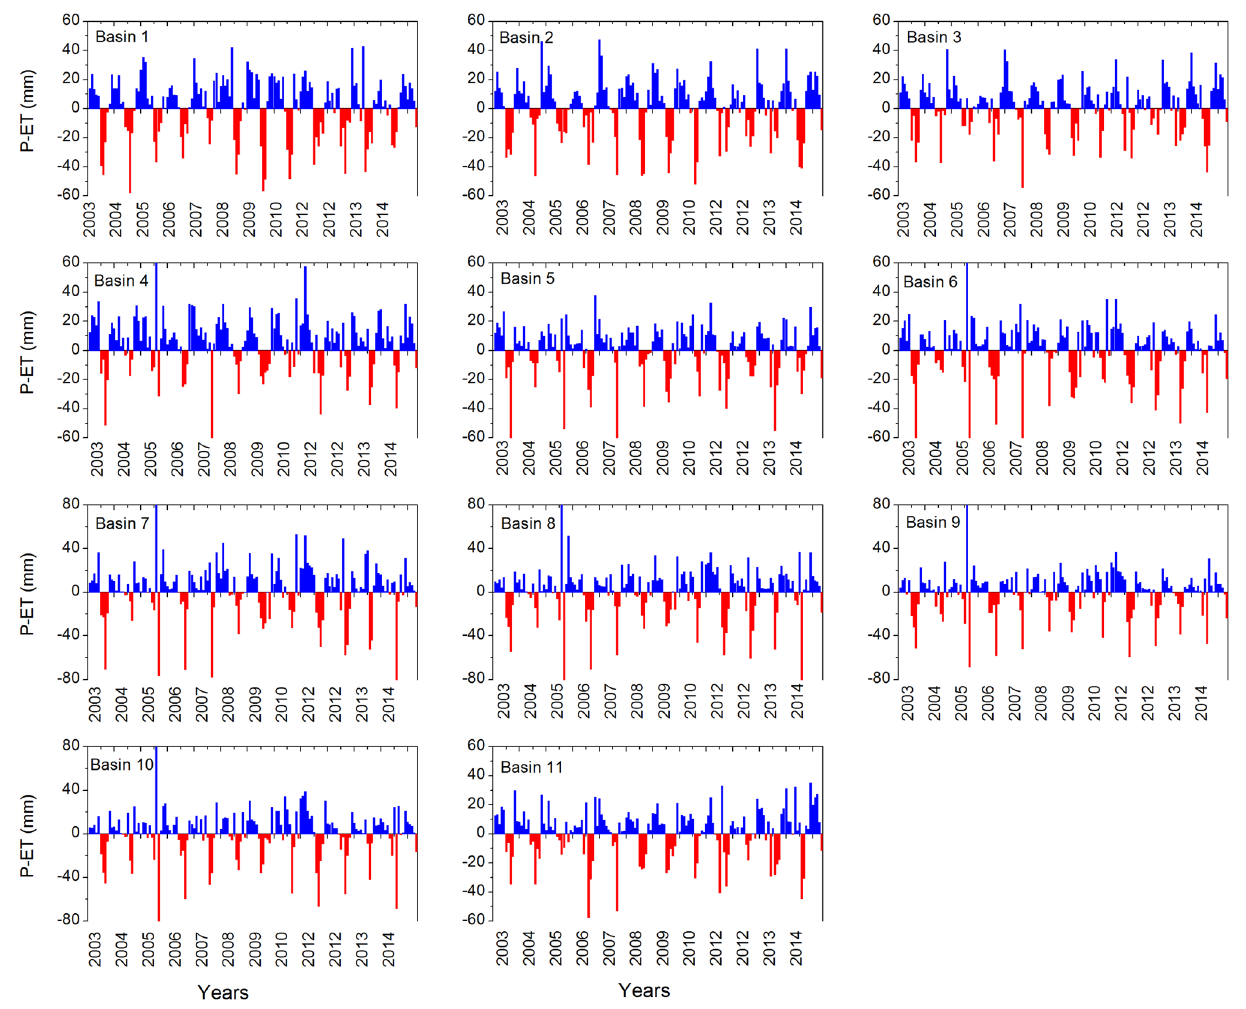
Figure 9. Basin-wide time series of P – ET values. Positive values are shown in blue and negative values are shown in